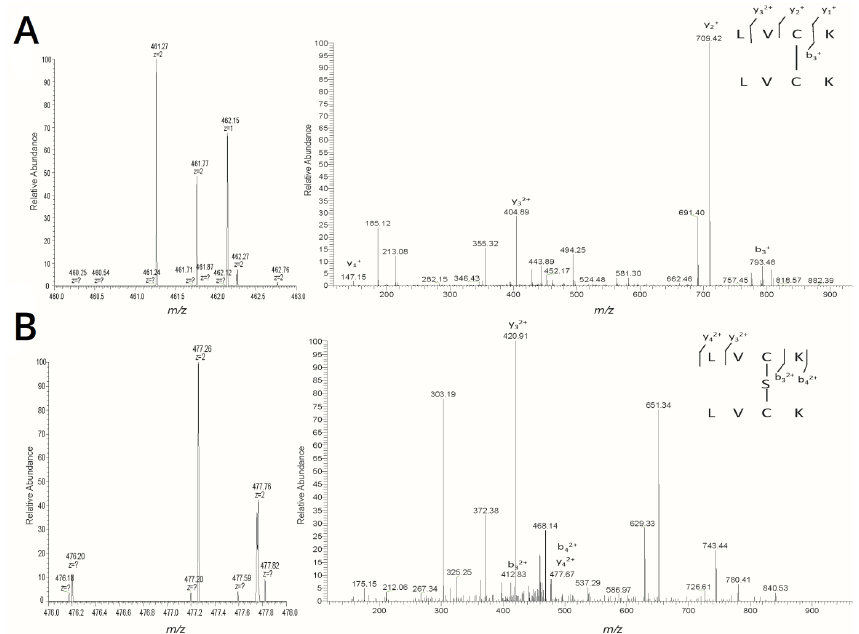
Figure 3 . LC–MS/MS analysis of H 2 S n -treated MarR. ( A ) Left: The 2 + charged peak ( m / z : 461.27) corresponding to the disulfide (Cys 80 -Cys 80 )-containing peptide (theoretical molecular mass: 921.53Da). Right: MS/MS fragmentation of the 2 + charged peptide ( m / z : 461.27). ( B ) Left: The 2 + charged peak ( m / z : 477.26) corresponding to the trisulfide (Cys 80 -S-Cys 80 )-containing peptide (theoretical molecular mass: 953.53 Da). Right: MS/MS fragmentation of the 2 + charged peptide ( m / z : 477.26). Peptide mass was calculated on the following website: